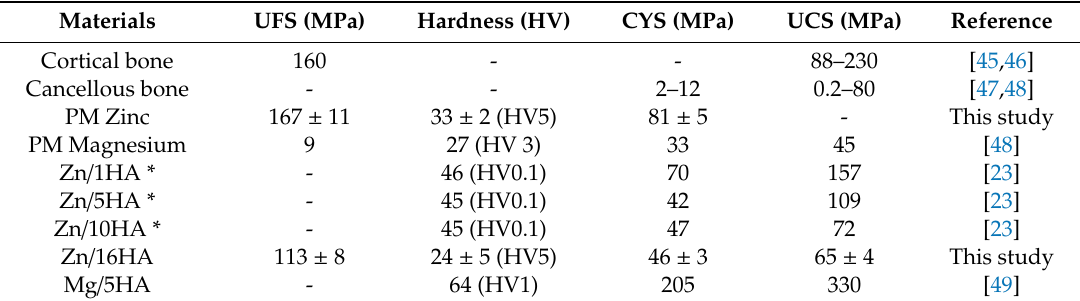
Table 3. The overview of mechanical properties (average values) of selected biodegradable materials and the human bone.